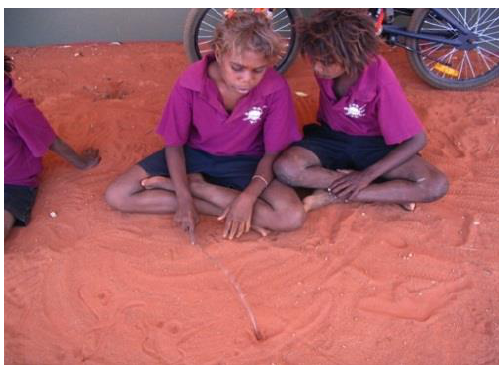
Figure 2. Telling stories in the